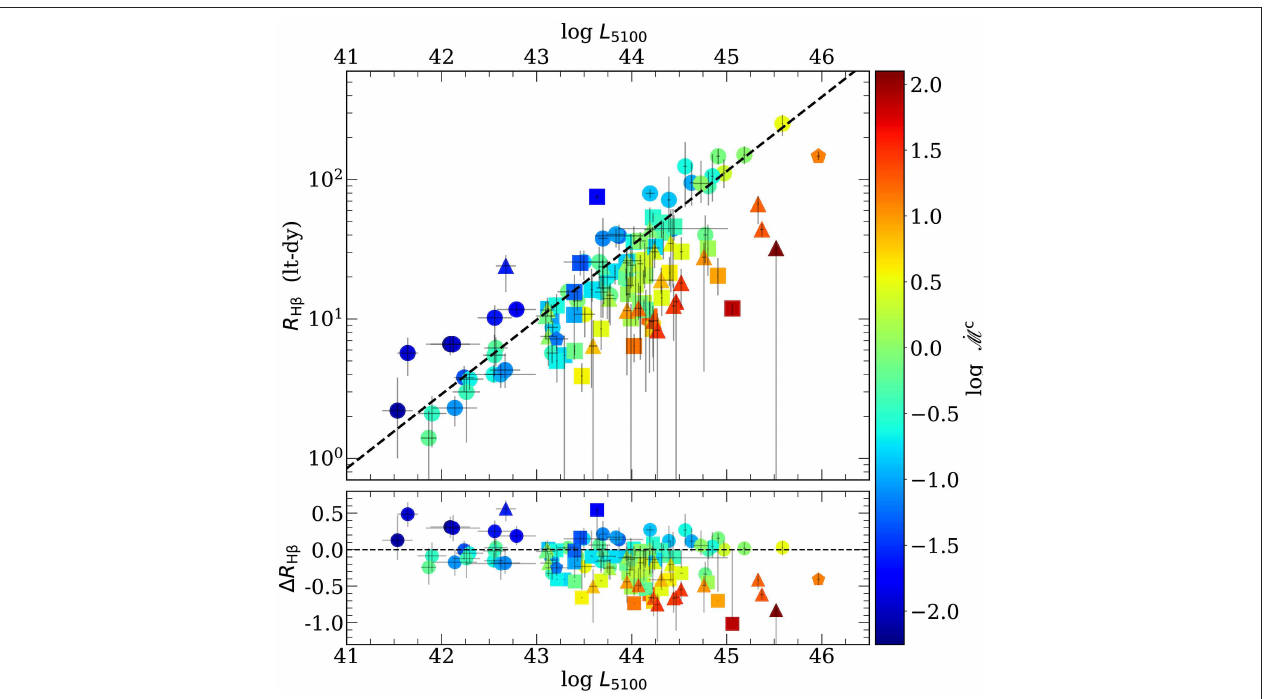
L 5100 relation for SEAMBH (triangles), SDSS-RM (squares), Bentz Collection (circles), NGC5548, and 3C 273 (pentagons). (Bottom) FIGURE 1 | (Top) R H β − Difference between the BLR size estimated from the observed time delay and the predicted ones by the RL relation (black line, Equation 1). In both panels, colors indicate the variation in dimensionless accretion rate, ˙ M c